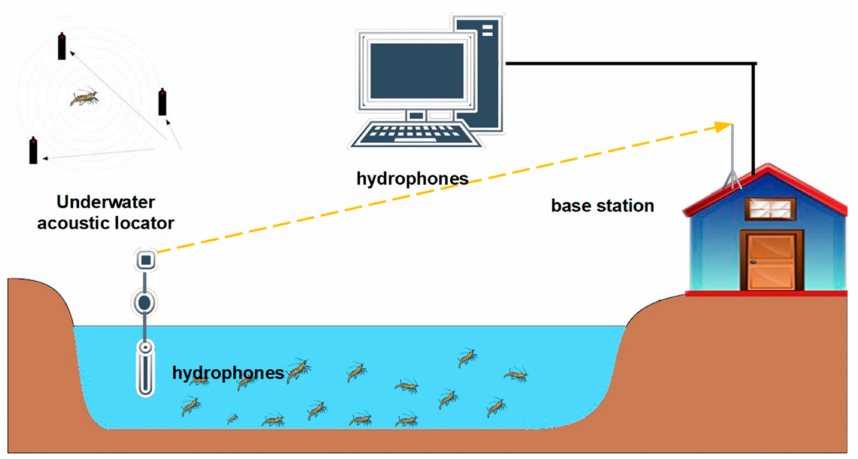
Figure 2. Acoustic technology